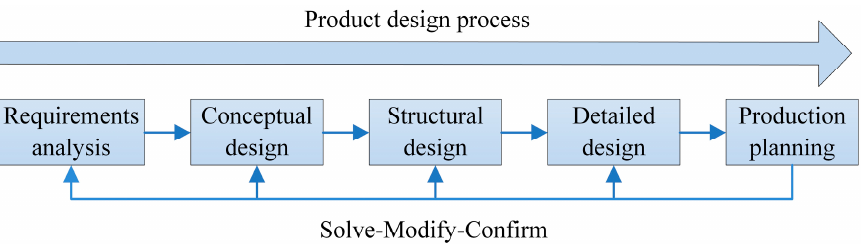
Figure 1. Product design